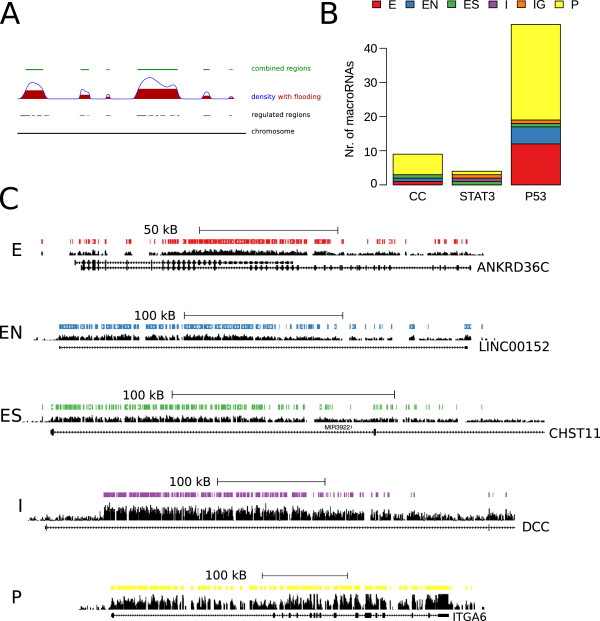
Genomic organization of DE-macroRNAs.(A) Schematic representation of the algorithm used to identify macroRNAs resembling the example in Figure 3A. DE and expressed intervals identified by TileShuffle are summarized as the density of positive nucleotides. Local maxima are identified and the density curve is ‘flooded’ to 50% of the local maximum to identify the boundaries of the region. Overlapping regions are merged and for each region a score based on coverage by positive nucleotides and silhouette is calculated. (B) Computationally identified macroRNAs with a score > 10,000 were manually inspected to discard false positives, which are typically long protein-coding genes with many exons interspersed by small introns. Identified DE-macroRNAs fall into different genomic categories: intergenic (IG), overlapping exons (E), overlapping non-coding exons (EN), located in introns (I), joint start but different end as coding RNA (ES) and presumed primary transcript (P). (C) DE-macroRNA examples for the E, EN, ES, I and P cases. The IG case is illustrated in Figure 3A. Only z-scores and selected transcript isoforms are shown. CC, cell cycle; E, overlapping exons; EN, overlapping non-coding exons; ES, joint start but different end as coding RNA; I, located in introns; IG, intergenic; kB, kilobase; Nr, number; P, presumed primary transcript; STAT3, signal transducer and activator of transcription-3.